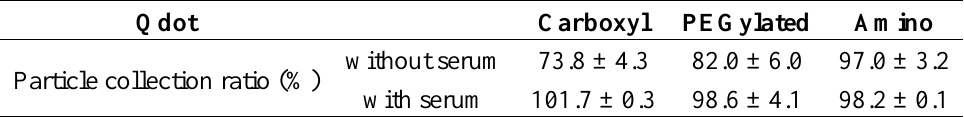
Table 2. Results of particle collection ratio in the BBB assay of Qdots (40